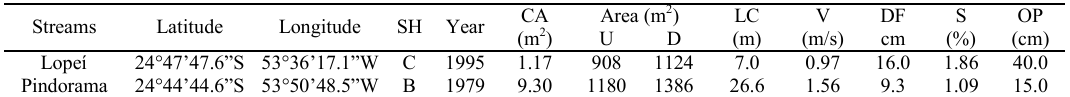
Table 1. Characteristics of study area. SH = Shape of the culverts, C = circular, B = box, Year = year of the roads construction, CA = cross-section area, U = upstream and D = downstream areas of culverts, LC = length of culverts, V = mean flow velocity (V), DF = mean depth of flow, S = slope, OP = outlet